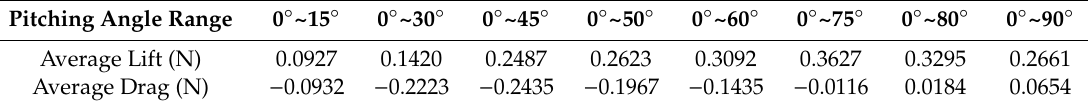
Table 4. Average lift and drag forces produced by the wing of di ff erent pitching angle ranges.